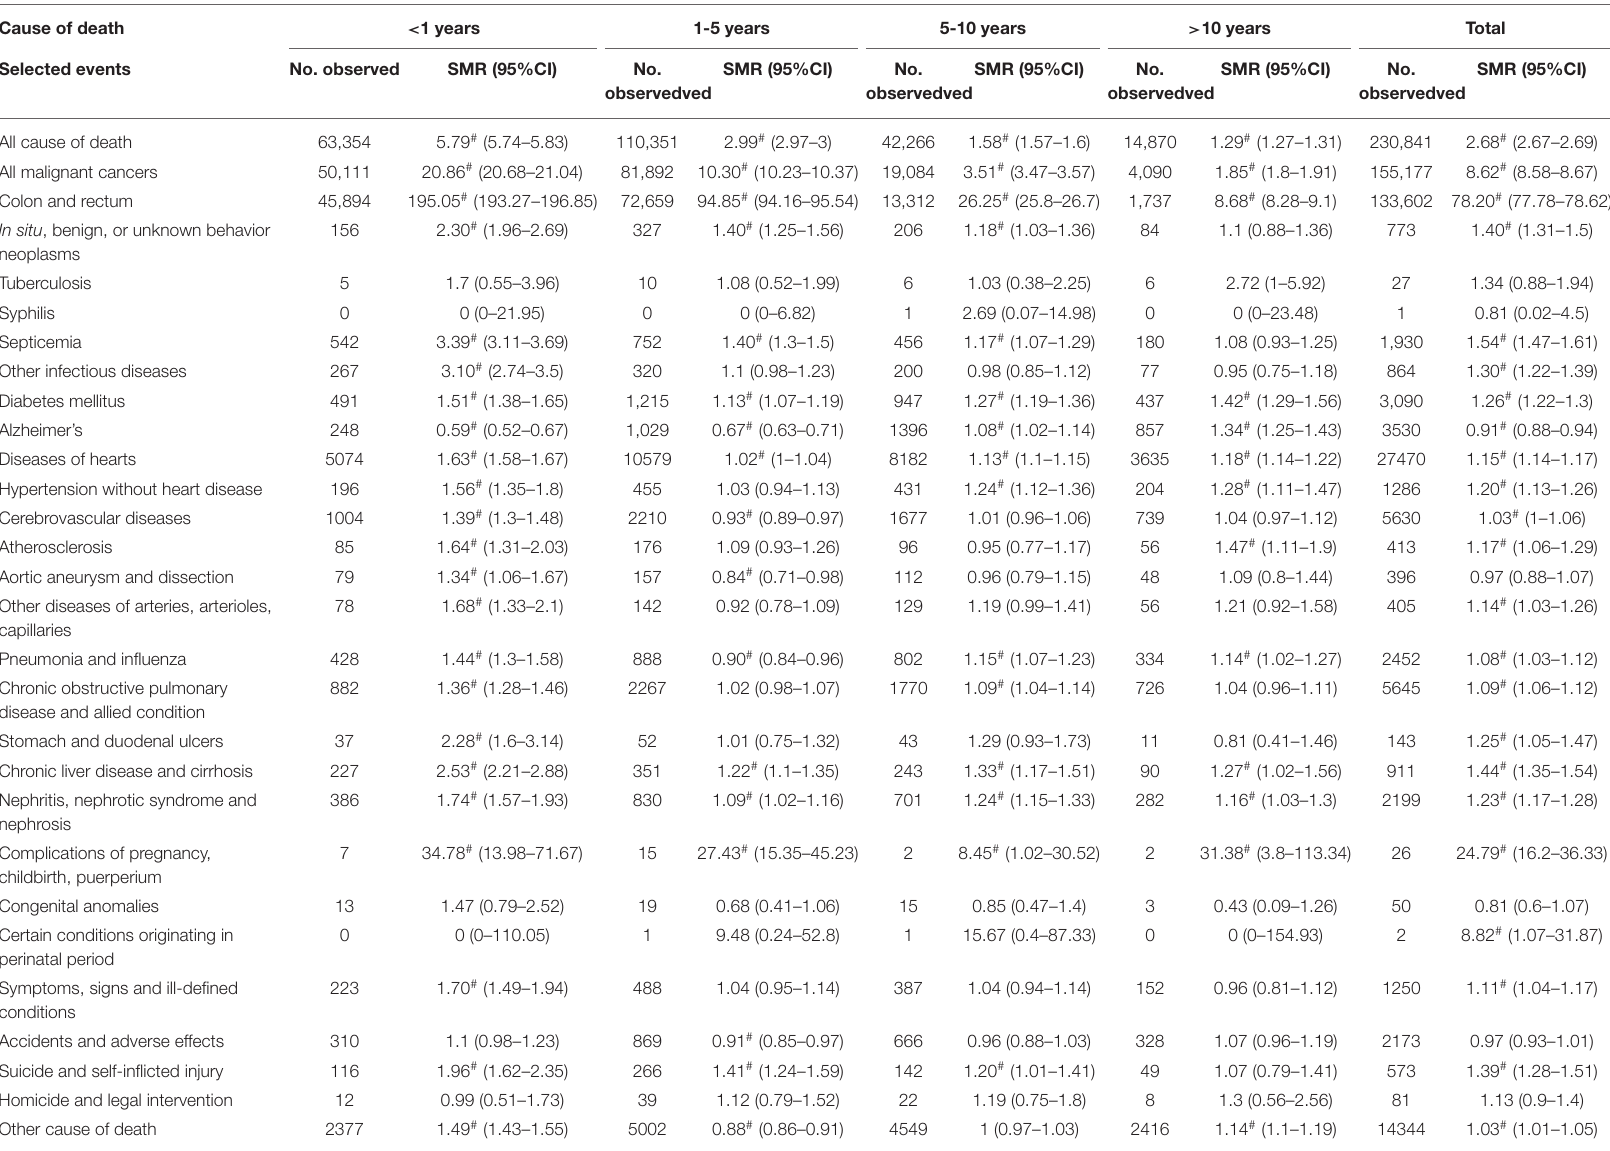
TABLE 2 | Standardized mortality ratios for each cause of death after CRC diagnosis. Timing of deaths after